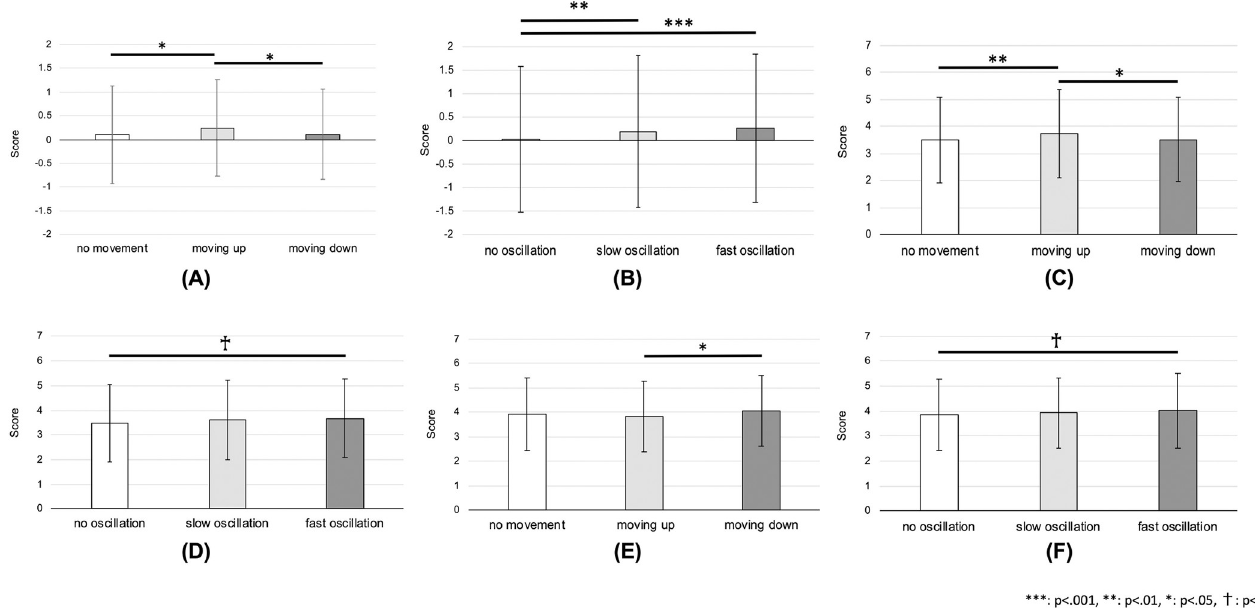
Fig 6. Results for joy and anger in short-term expressions. Score of the expressivity and clarity by different vertical transitions or oscillations of the robot in the case of the short-term representation of joy and anger: (A) expressivity of joy by vertical transition and (B) by vertical oscillation, (C) clarity of joy by vertical transition and (D) by vertical oscillation, (E) clarity of anger by vertical transition and (F) by vertical oscillation. Note that for the expressivity, the improvement of the score is shown as explained in the paper.